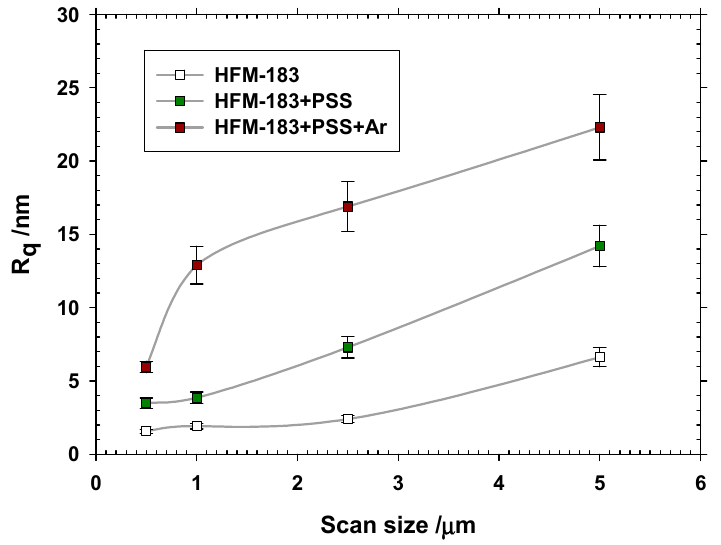
Figure 3. Roughness versus scan size.